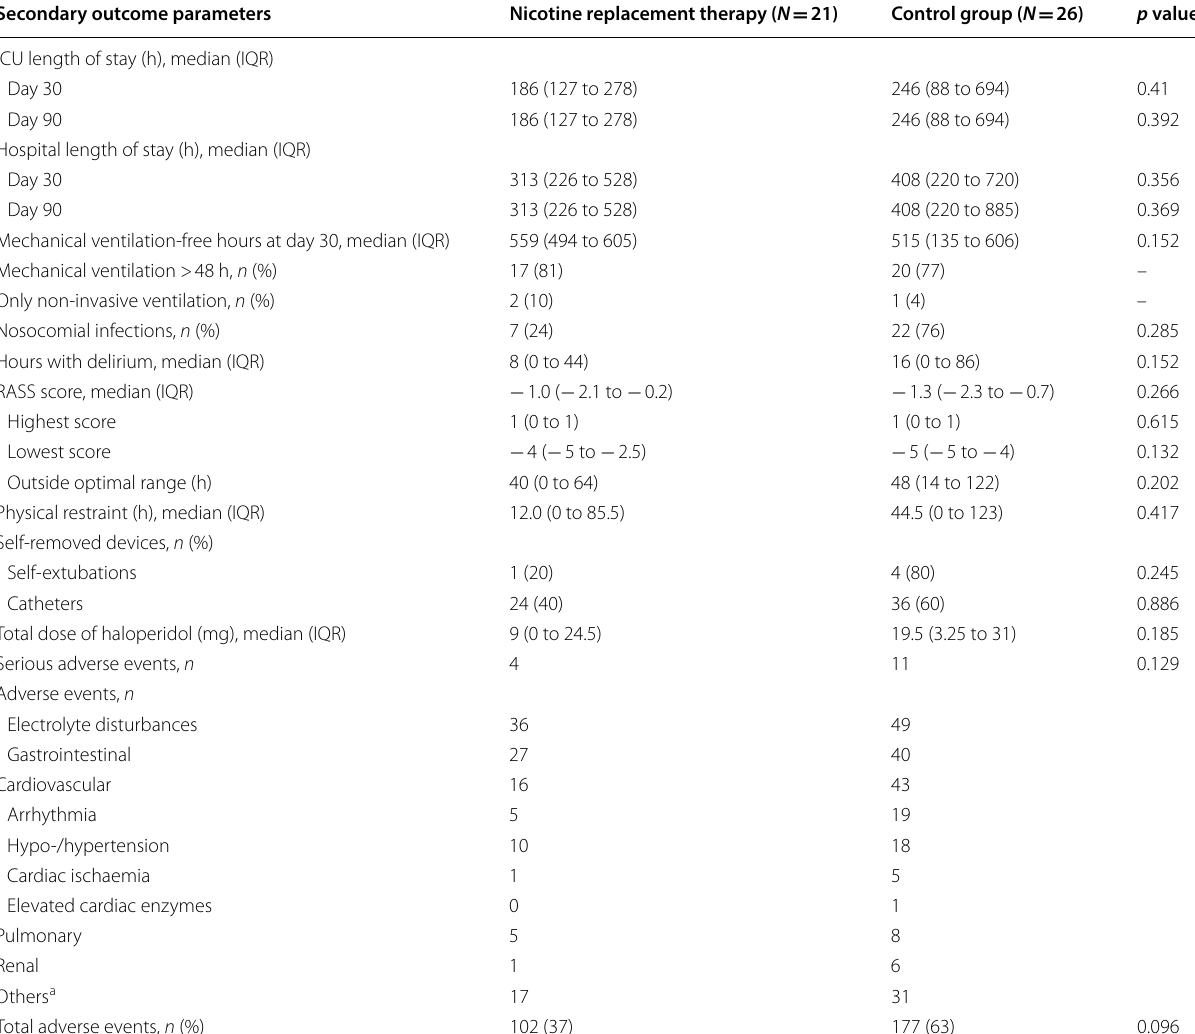
Table 2 Secondary outcome